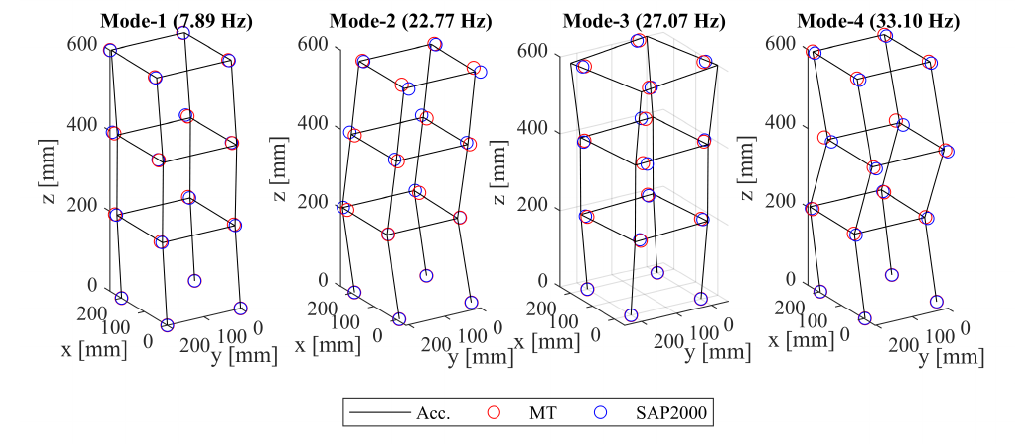
Figure 10. Comparison between the normalized mode shapes obtained via accelerometers and SAP2000, and the operational deflection shapes via 3D-MT using a “coarse” grid (scaled for better visualization).